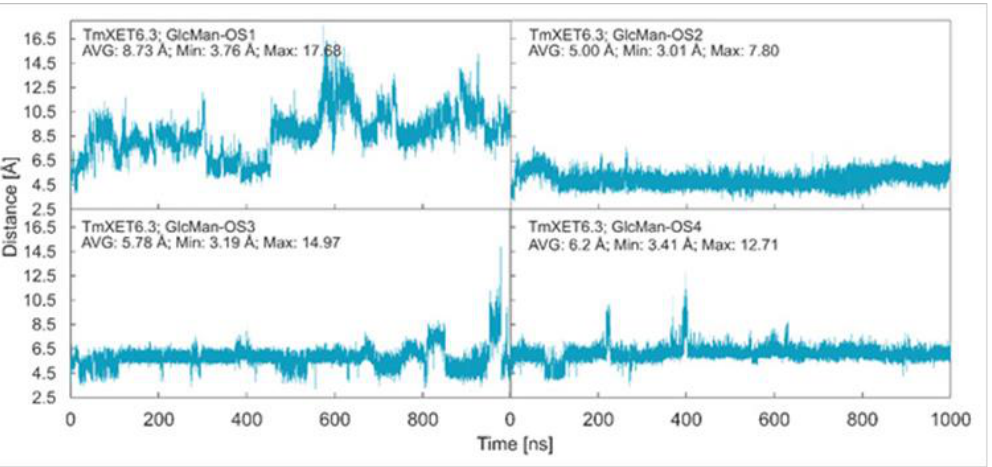
Figure 8. Time dependence of the distance (Å ) between the C1 atom of the XG-OS7 donor and the O4 atom of the GlcMan-OS acceptor during MD simulations with TmXET6.3. The C1 and O4 atoms form a glycosidic bond.